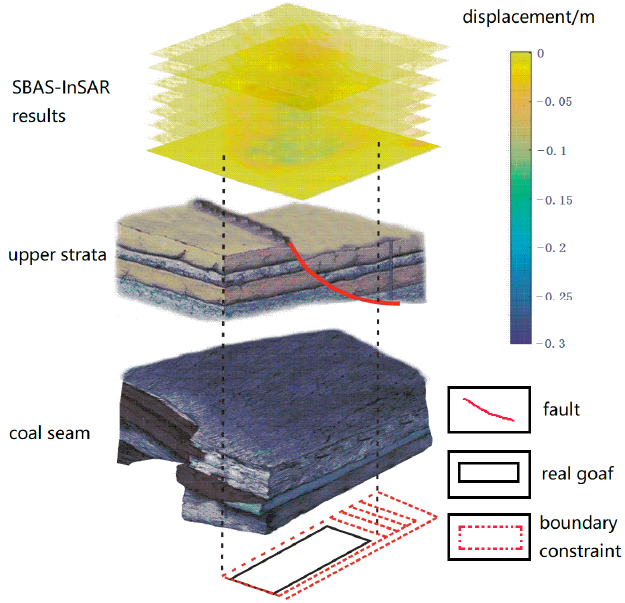
Fig 10 Figure 10. Sketch map of the proposed method with the boundary constraint.